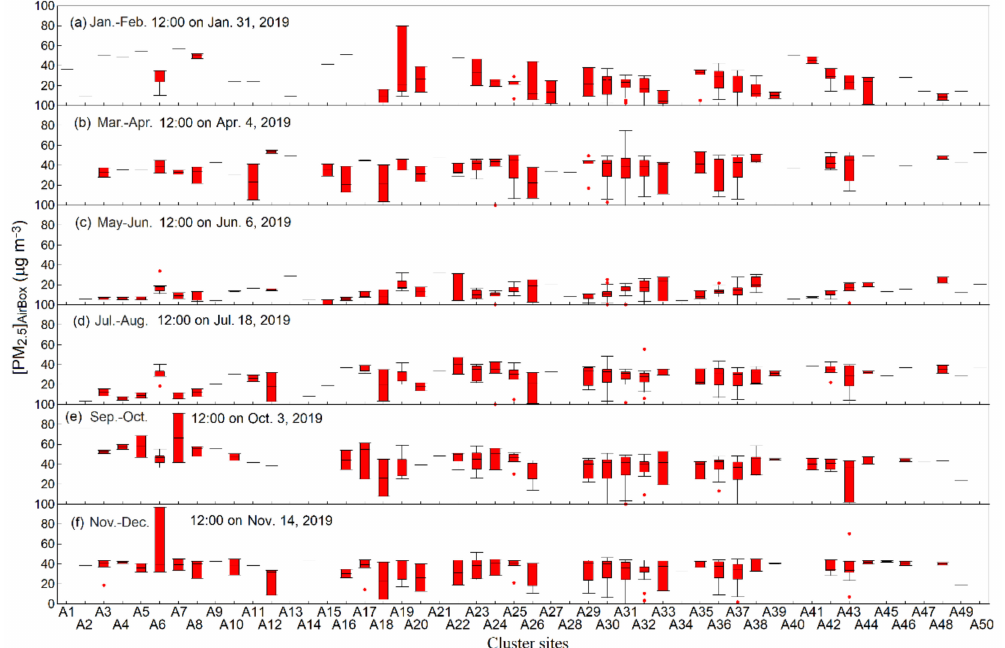
Figure 10. Box-whisker plots and outliers (red dots) of observed data from the clusters of AirBox sensor system at 12:00 p.m. Thursday of representative week in six two-month periods of